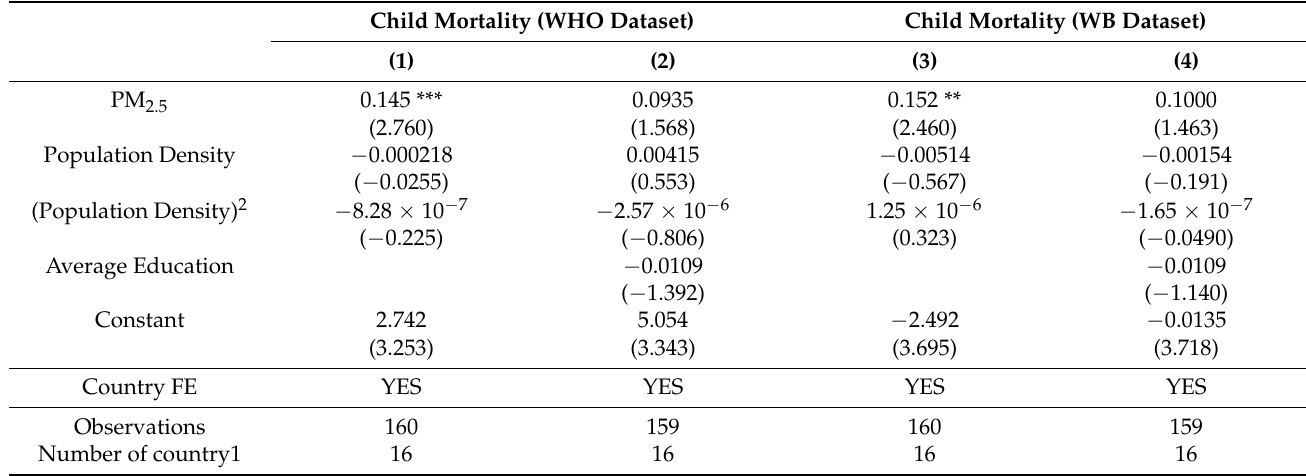
Table 3. Second-stage estimation on child mortality. Child Mortality (WHO Dataset) Child Mortality (WB